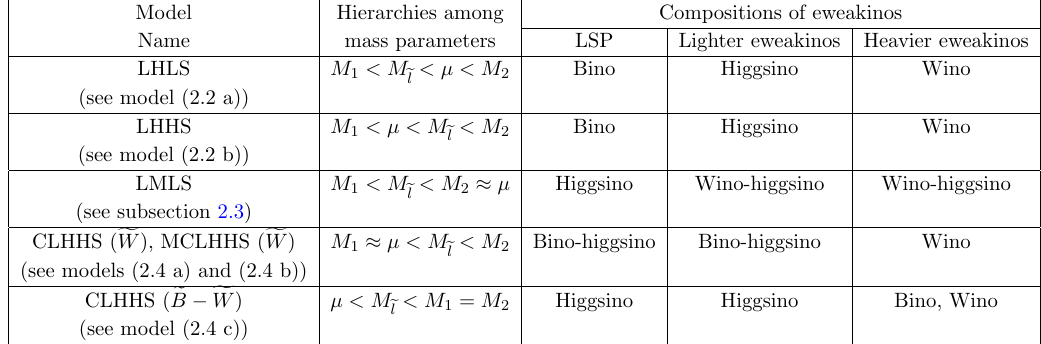
Table 1 . Hierarchies among mass parameters for di(cid:11)erent models described in detail in section 2. The compositions of eweakinos in each case are also